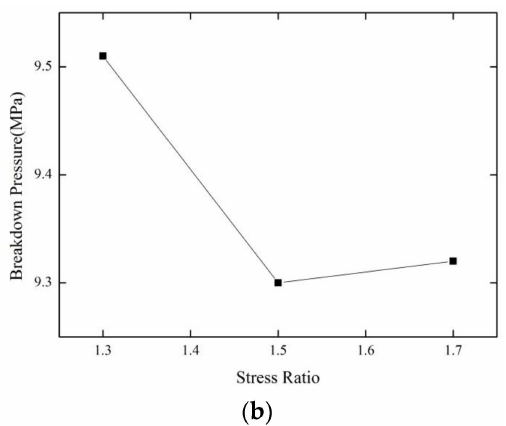
Figure 16. The relationship between stress ratio and hydraulic fracturing characteristics. ( a ) relationship between stress ratio and the fracture aperture; ( b ) relationship between stress ratio and the breakdown